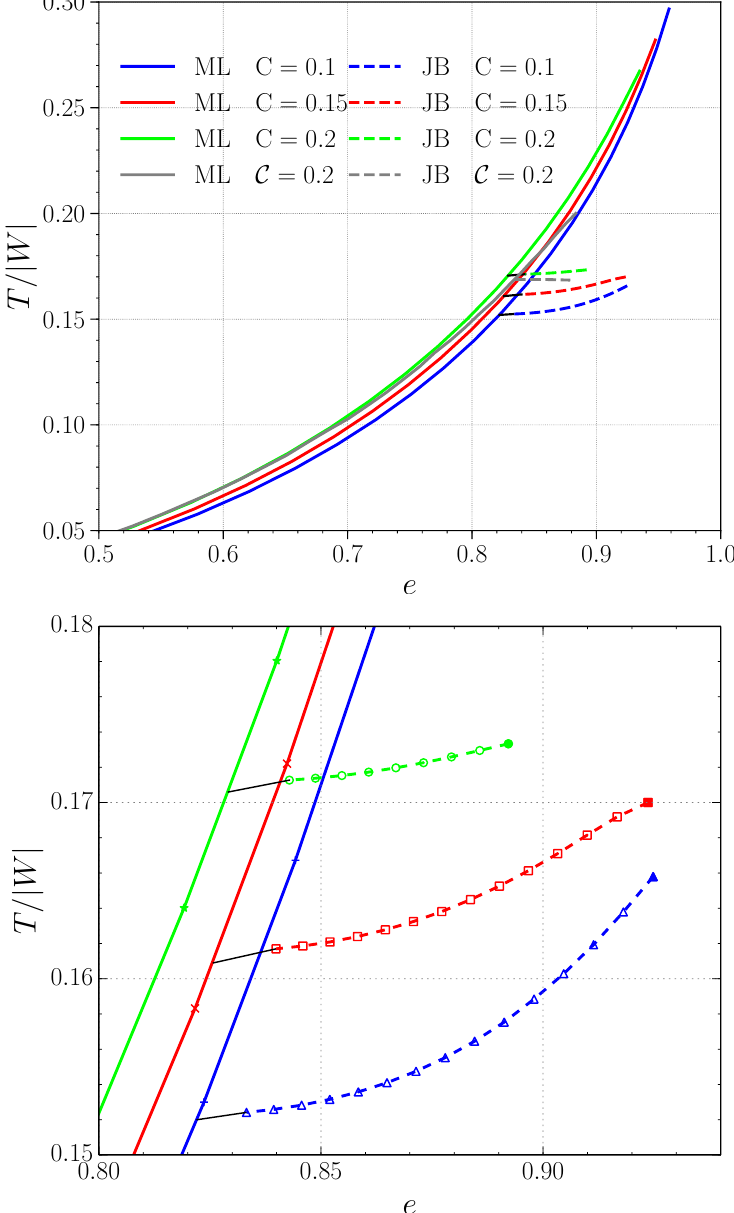
(cid:112) ( z / x ) 2 (in proper length) for the MIT W Figure 2. Upper panel: T / versus eccentricity e : = 1 | | − bag-model Equation of State (EoS) sequences as well as for NSs with n = 0.3 EoS reported in [21] (labeled with gray curves). Solid curves are axisymmetric solution sequences, and dashed curves are = M / R = 0.2 (green curves), 0.15 (red curves), and triaxial solution sequences, which correspond to C 0.1 (blue curves), respectively. Note that M is the spherical ADM mass. Lower panel: Magnification of the region near the onset of the triaxial solutions marked with empty symbols. Filled symbols mark the models at the mass-shedding limit. Solutions labeled with “ML” are axisymmetric solutions (Maclaurin spheroids), while those labeled “JB” are triaxial solutions (Jacobi